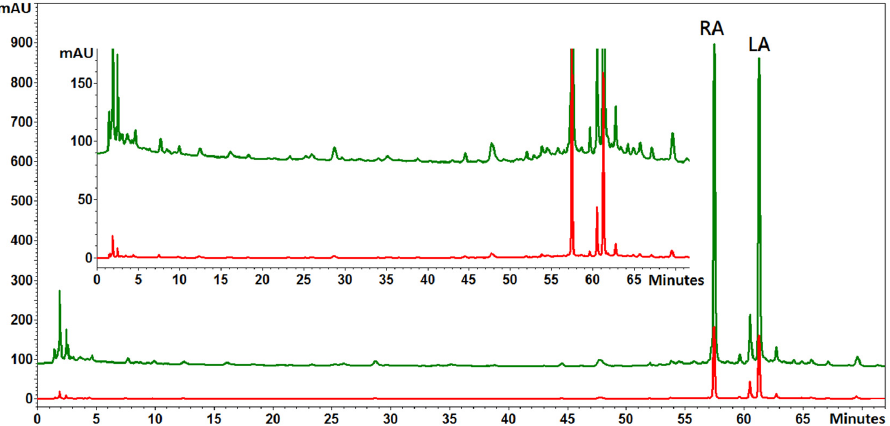
Figure 4. Comparison of chromatograms of Melissa officinalis leaf extracts (evaluated by HPLC-UV-MS) from control plants (red line) and from plants treated with 100 mM NaCl (green line); RA, rosmarinic acid; LA, lithospheric acid.